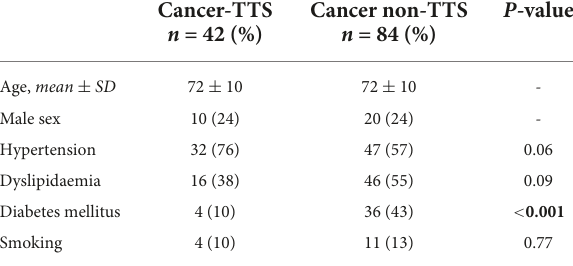
TABLE 2 Clinical features of cancer-TTS patients and matched cancer non-TTS ones.